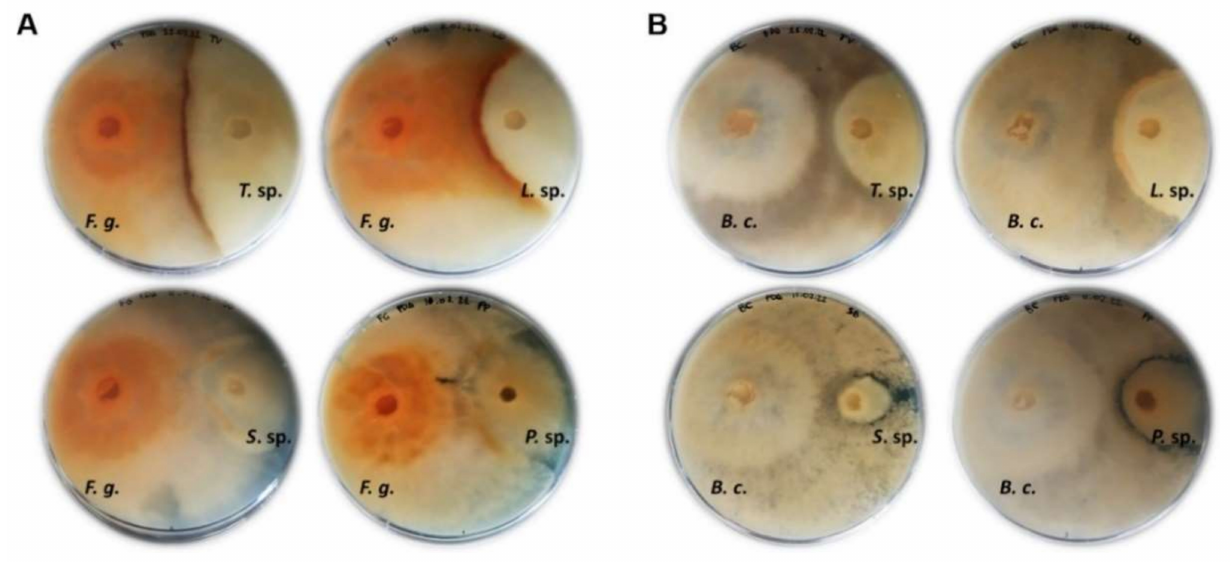
Figure 7. Co-cultivation of Fusarium graminearum ( A ) and Botrytis cinerea ( B ) (on the left of the plates) and Antarctic fungal isolates on PDA solid medium at 10 dpi. F. g .: Fusarium graminearum ; B. c .: Botrytis cinerea ; T . sp.: Trametes sp.; L . sp.: Lenzites sp.; S . sp.: Sistotrema sp.; P . sp.: Peniophora